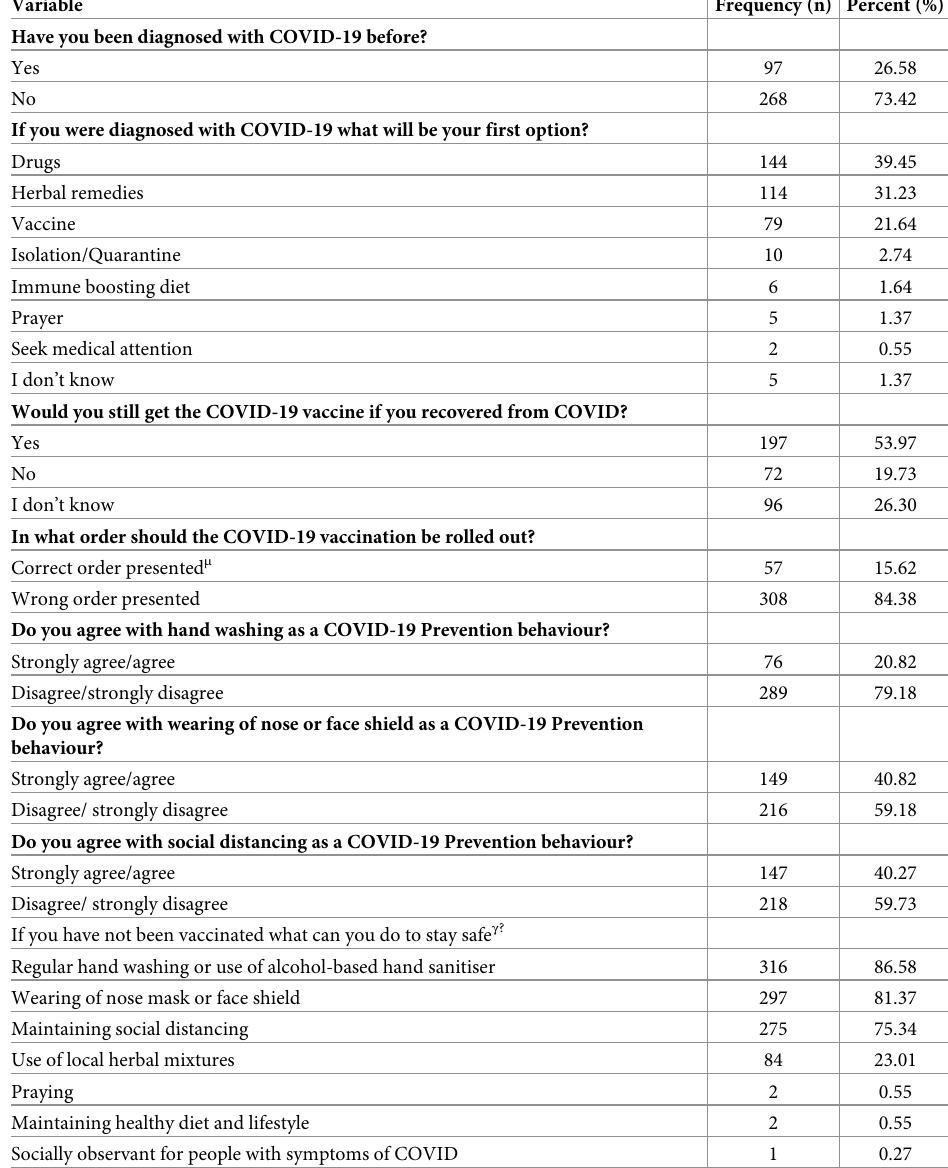
Table 3. Public knowledge on COVID-19 vaccinations (n =